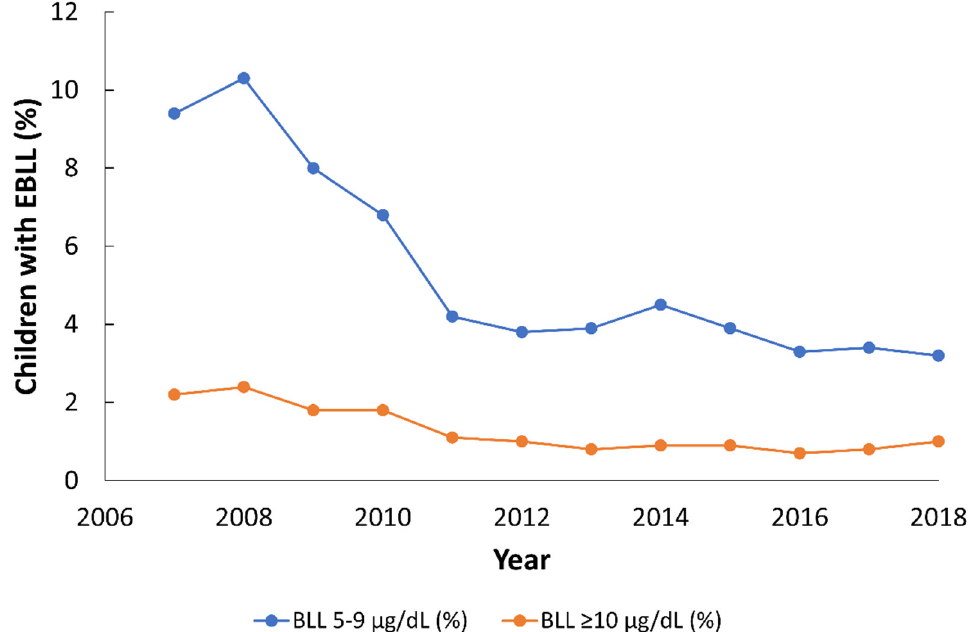
Figure 1. Evolution of the percentage of children with elevated blood lead levels (EBLL), i.e., Pb in blood ≥ 5 µg/dL, from 2007 to 2018. All data are from the city of Philadelphia’s Childhood Lead Poisoning Surveillance Report (2019). The total number of children screened ranged from 35,456 (2014) to 39,146 (2010).